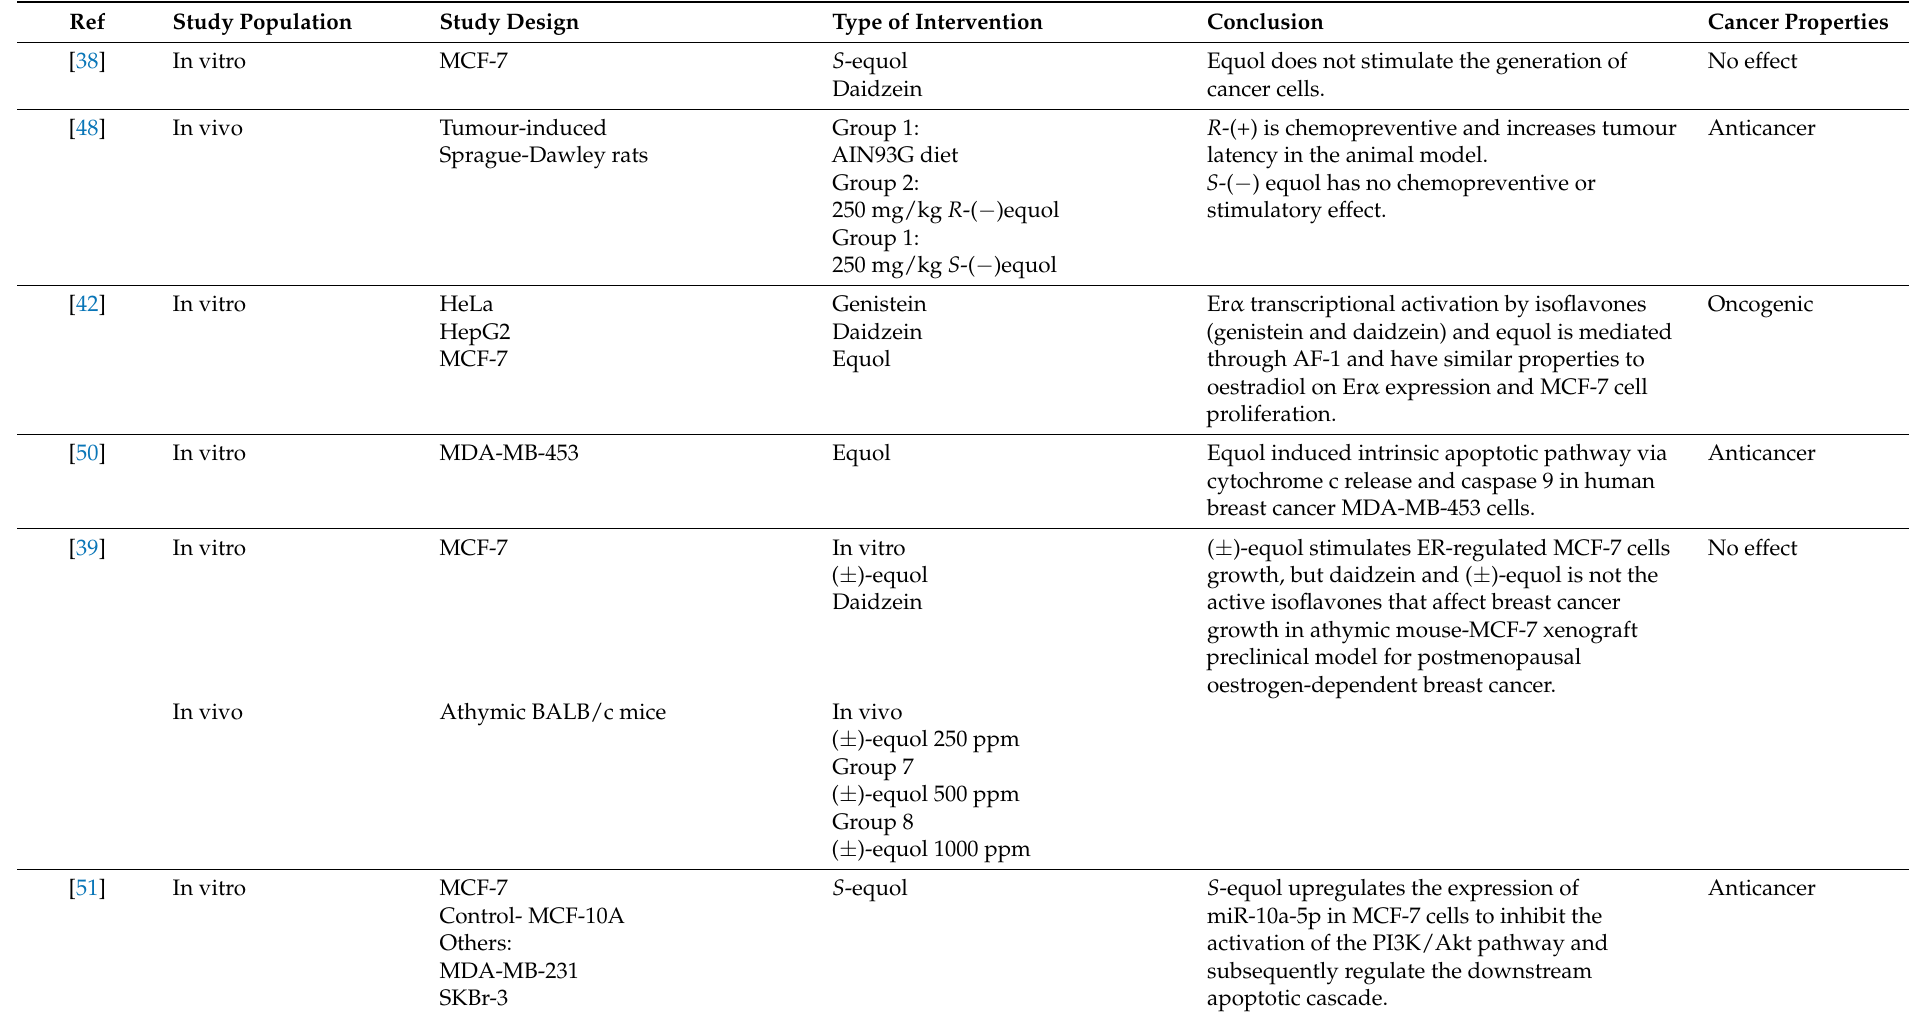
Table 2. Characteristics of relevant